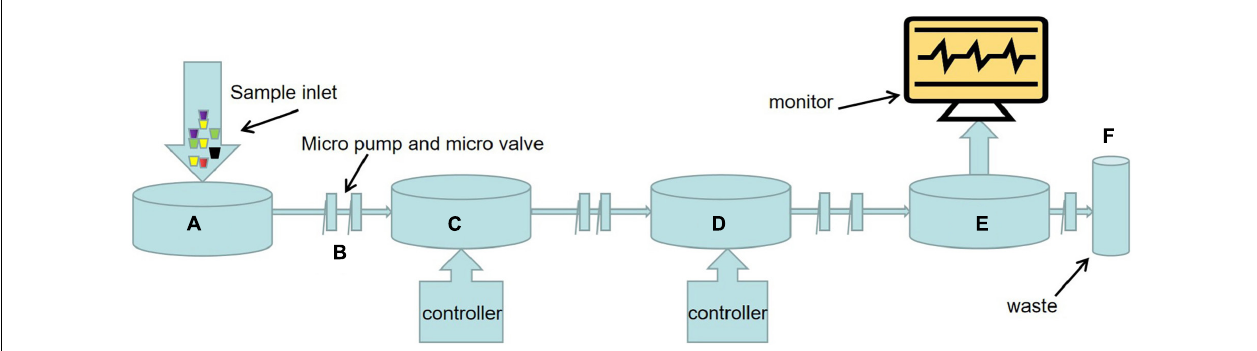
FIGURE 1 | Schematic diagram of LOC process for nucleic acid detection of food and environmental microorganisms. (A) Sample injection. (B) There are a large number of micro-pumps and micro-valves on the chip to precisely control the flow direction and flow rate of microfluids. (C) Sample preparation including pathogen capture, cell lysis, nucleic acid extraction and purification, etc. The methods of pathogen capture mainly include microsphere, filter or membrane, dielectrophoresis, magnetophoresis, acoustophoresis, etc. This part often needs external electric field, magnetic field, ultrasonic, and its strength is controlled by the controller. (D) Nucleic acid amplification. In addition to traditional PCR, various emerging isothermal nucleic acid amplification techniques have been applied to LOC equipment. The substrate used for nucleic acid amplification is packed into a micro chamber in advance, and the temperature of the reaction process is controlled by a temperature controller. (E) Sample detection devices, primarily sensors. Such as fluorescence sensors, surface plasma resonance (SPR) sensors, surface enhanced Raman scattering (SERS) sensors, electrochemical biosensors. (F) Results are visually displayed on the